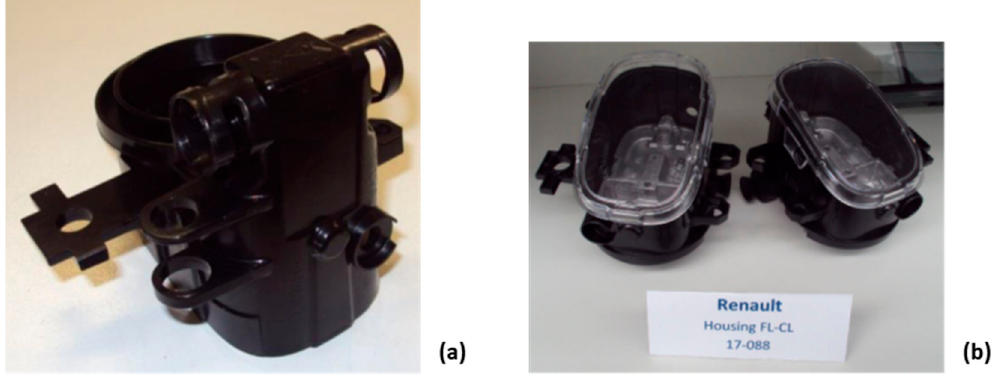
Figure 15. Finished product ( a ) and left and right product in fog light assembly ( b ).